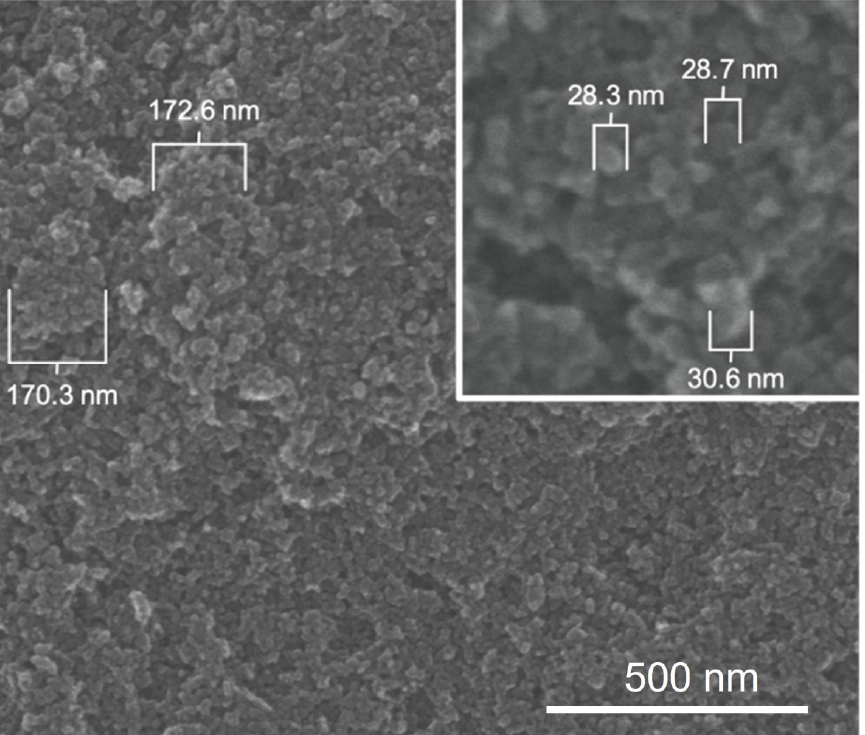
Figure 5. Scanning electron micrographs of E1800 (solvent casting method) showing primary carbon nanoparticles approximately 29 nm in diameter (inset) and aggregates of approximately 170 nm formed by primary particles.